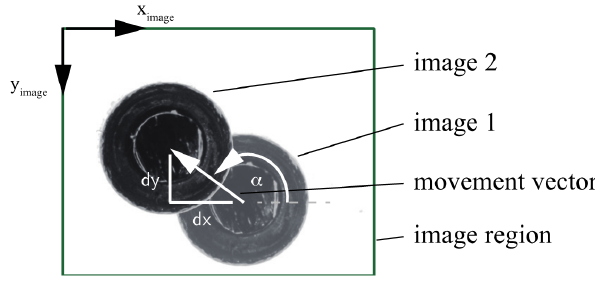
1 Fig. 6: Images before and after a movement have been overlaid. The camera orientation is 2 calculated by comparing the robots movement and the vector described by the reference mark. 3 Figure 6. Images before and after a movement have been over- laid. The camera orientation is calculated by comparing the robot’s movement and the vector described by the reference mark.